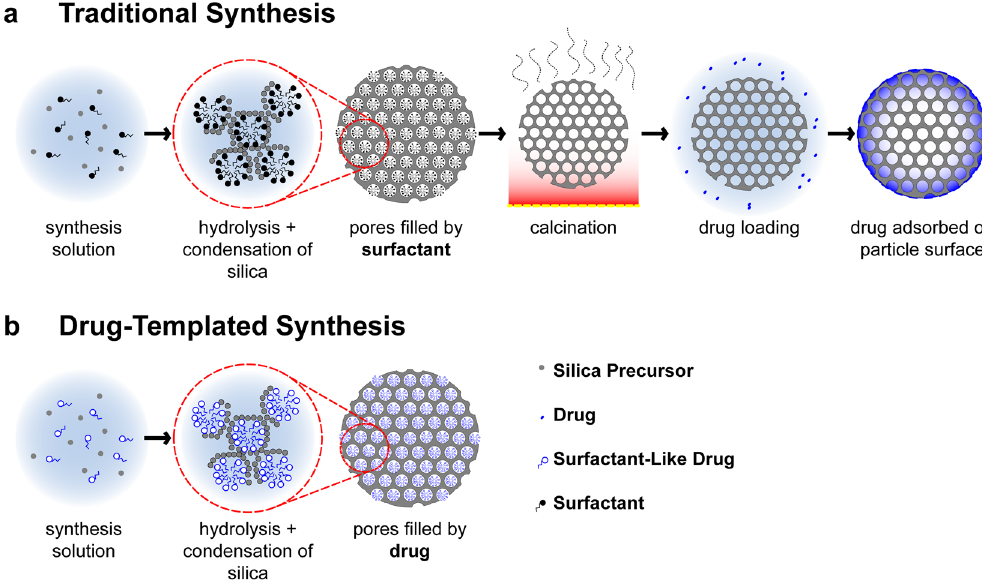
Figure 1. Drug-templated synthesis of MSNs ( b ) significantly simplifies synthesis and yields vastly different drug-loading and release results when compared to traditional concentration-gradient driven loading ( a